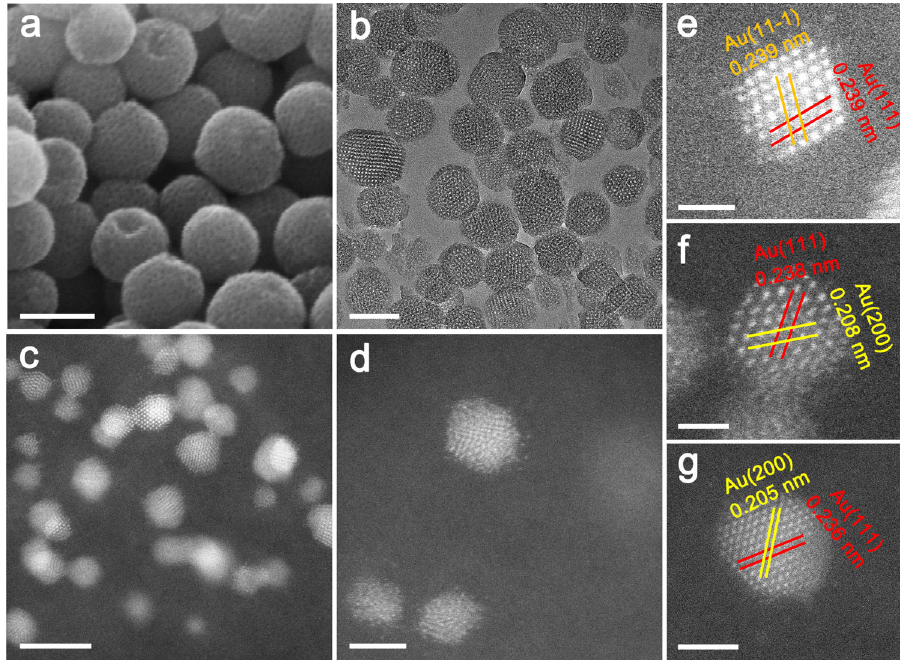
Fig. 1 Electron micrographs. a Representative HRSEM image, b TEM image of an ultrathin section, c , d HAADF-AC-STEM images for fresh C – Au-2.4/ OMC; AC-STEM images for fresh e C – Au-1.6/OMC, f C – Au-2.4/OMC, and g C – Au-3.9/OMC. The scale bar is 100 nm for ( a , b ), 5 nm for ( c ), 2 nm for ( d , g ), and 1 nm for ( e , f